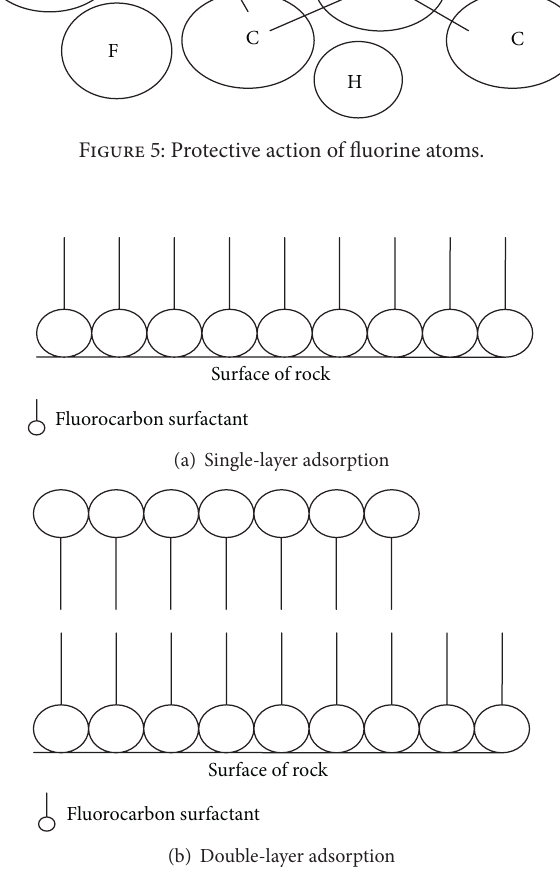
Figure 6: Adsorption of the Fluorocarbon Surfactant on the Surface of